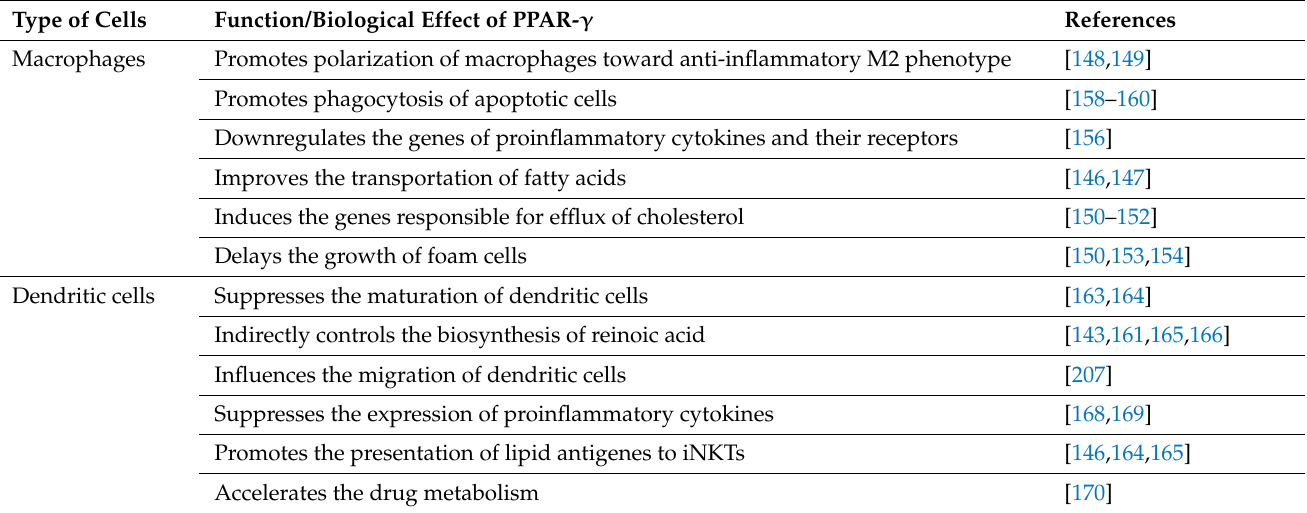
Table 1. The role of PPAR- γ in immune